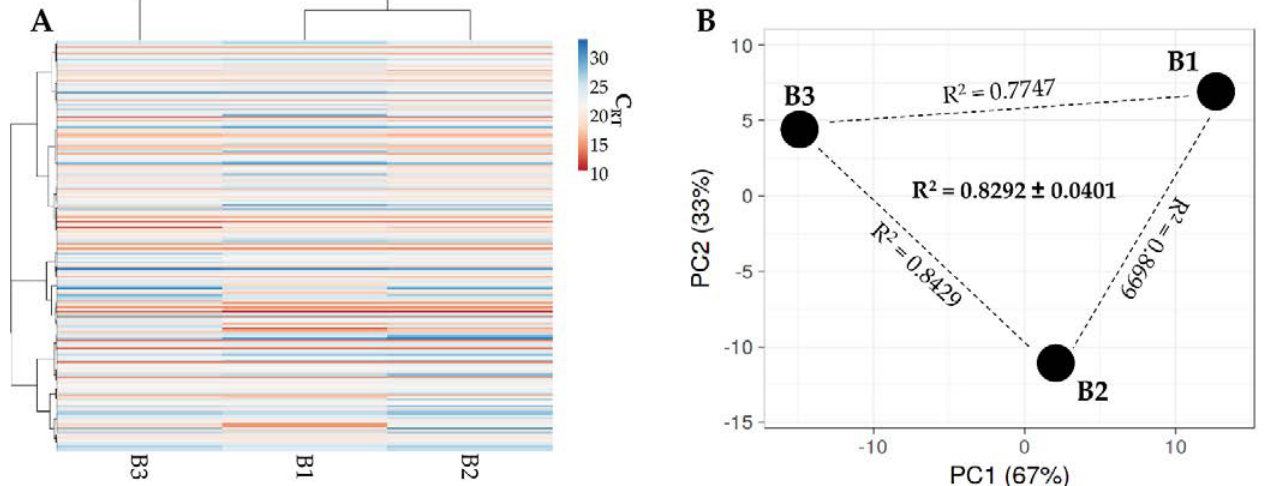
Figure 6. Comparison of EV-miRNA expression profiles between BMSCs under study. ( A ) heat map of hierarchical clustering analysis of the normalized C RT values of detected miRNAs with sample clustering tree at the top. Absolute expression levels are indicated by the color scale: blue shades = low expression levels (high C RT values) and red shades = high expression levels (low C RT values). ( B ) Principal component analysis of the normalized C RT values of detected miRNAs. X and Y axes show principal component 1 and principal component 2 that explain 67% and 33% of the total variance. Table 2. First quartile EV-miRNAs.